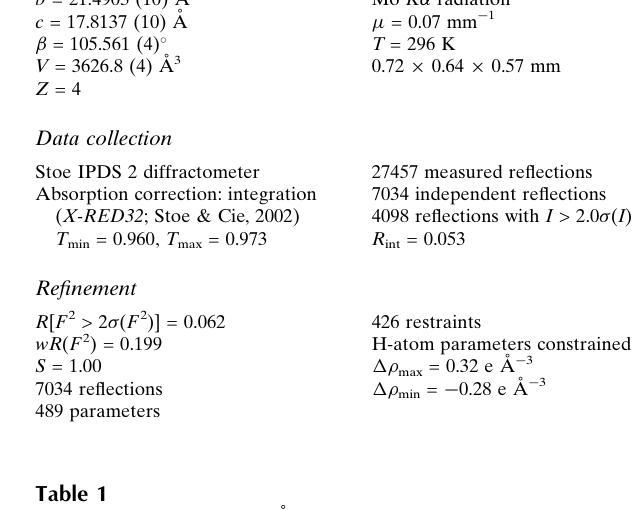
Hydrogen-bond geometry (A˚ , (cid:1)